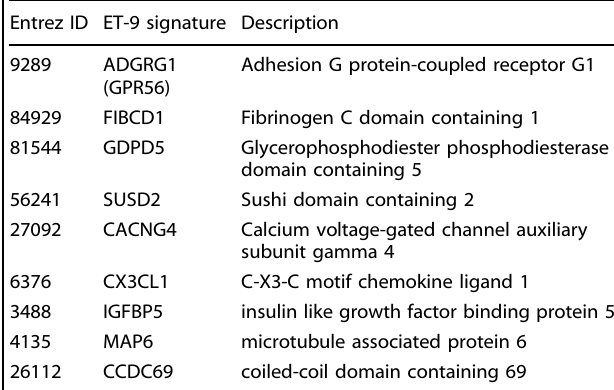
Table 1. The list of genes in the ET-9